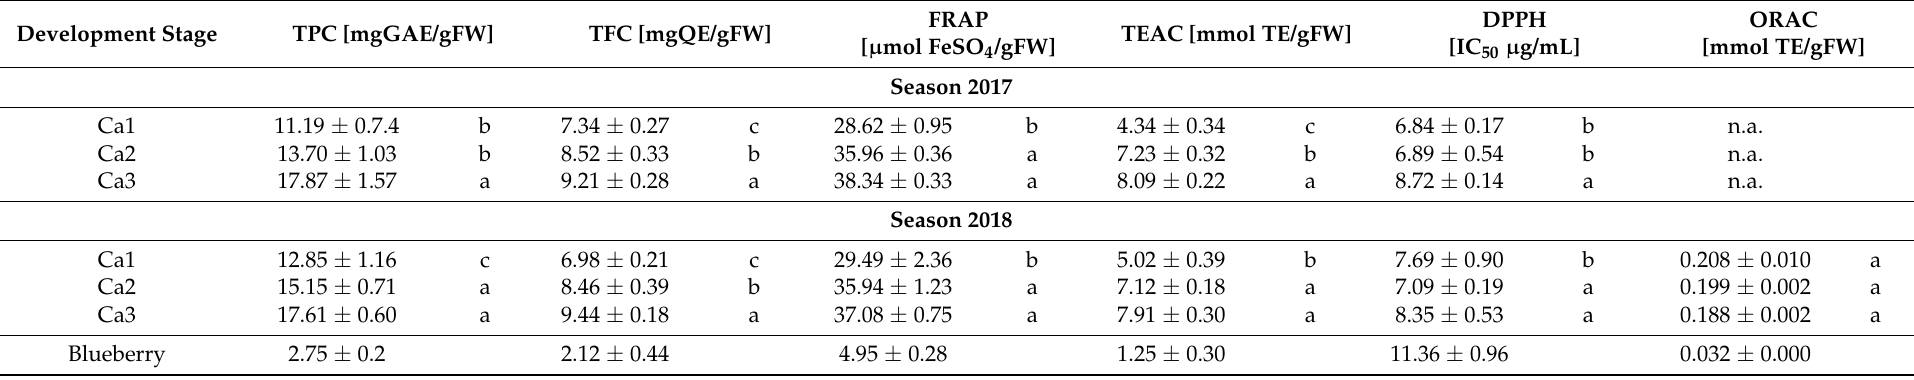
Table 2. Total polyphenol content (TPC), total flavonoid content (TFC), antioxidant capacity by FRAP, TEAC, DPPH, and ORAC methods, during the development of peumo fruits for the 2017 and 2018 harvest seasons. GAE, gallic acid equivalent; QE, quercetin equivalent; TE, trolox